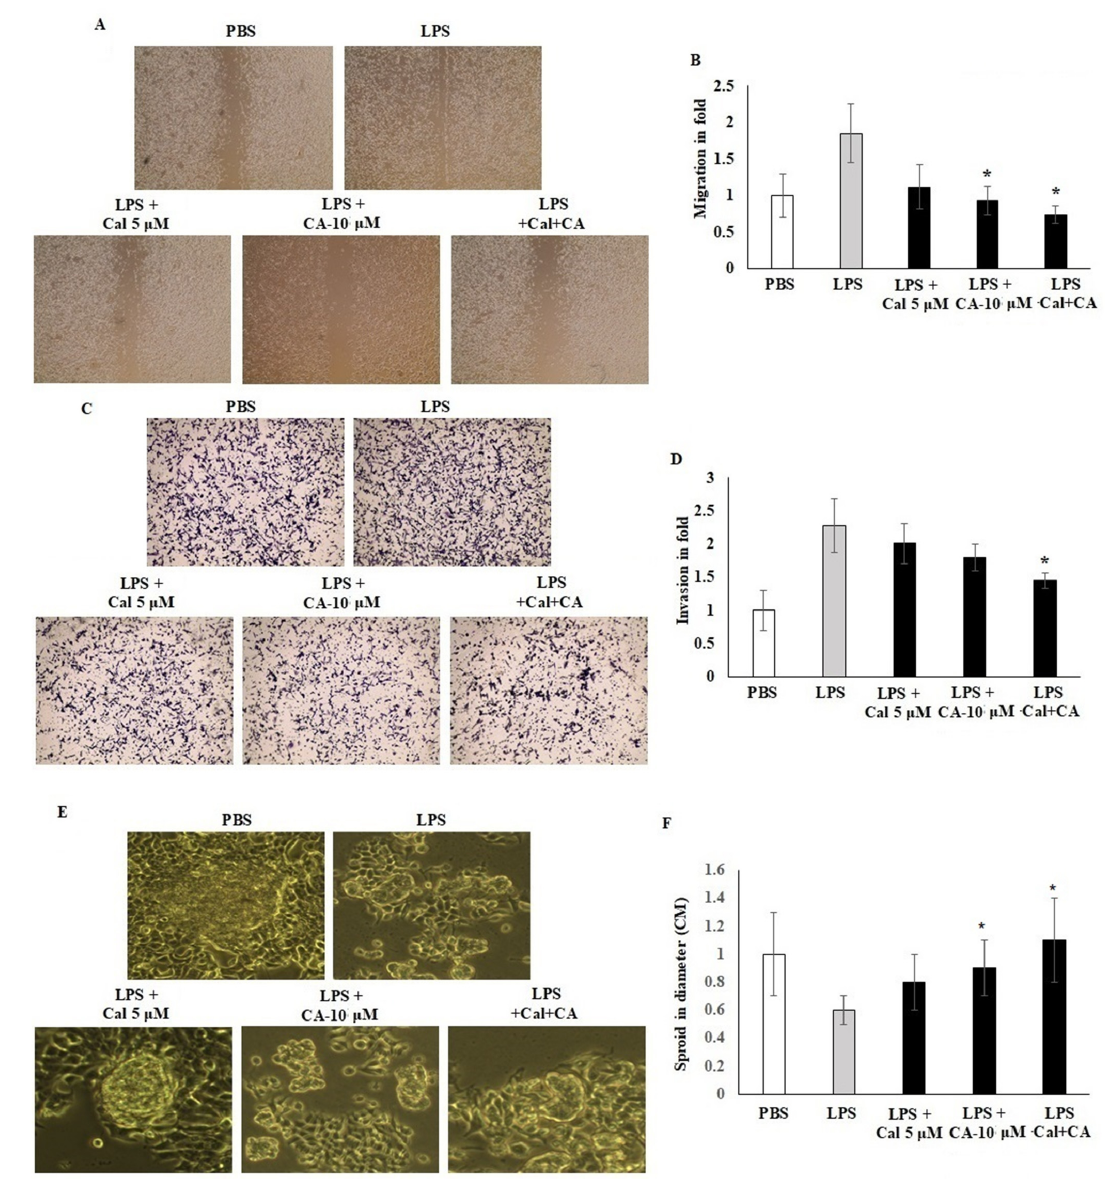
Figure Figure 4. CA inhibits HCT116 colon cancer cell migration and Transwell-based invasion. ( A,B ) HCT116 cell monolayers were scratched after 60% confluency and cells were exposed to CA (10 μ M) and Cal (5 μ M) alone and combined treatment. Treated cells were incubated for 24 h in appropriate culture conditions. Migration was observed with an optical micro- scope (200× magnification) using a scratch wound assay. ( C,D ) HCT116 cells supplemented with CA (10 μ M) and Cal (5 μ M) lone and combined treatment to the insert of Matrigel-coated trans wells, and invasion was inspected via total cell counting under the adhesive part of insert. Invading cells quantified by using image J-based counting method. ( E,F ) CA alone and in combination with Cal regulated the sphere formation. HCT116 Cells were supplemented with CA (10 μ M) and Cal (5 μ M) alone and combined for 7 days. The mammosphere formation of treated cells was compared with untreated and LPS-induced cells. After 7 days, cells were photographed and measured the sphere diameter using an ImageJ micros- copy tool. All phase-contrast images of HCT116 cells that were treated with CA and CAL alone and in combination using